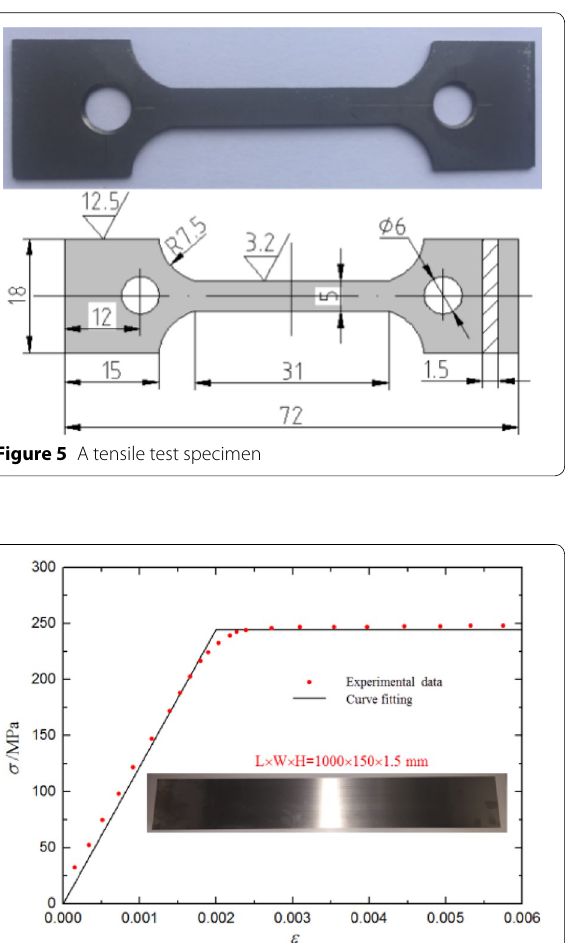
Figure 6 Experimental plate parameters